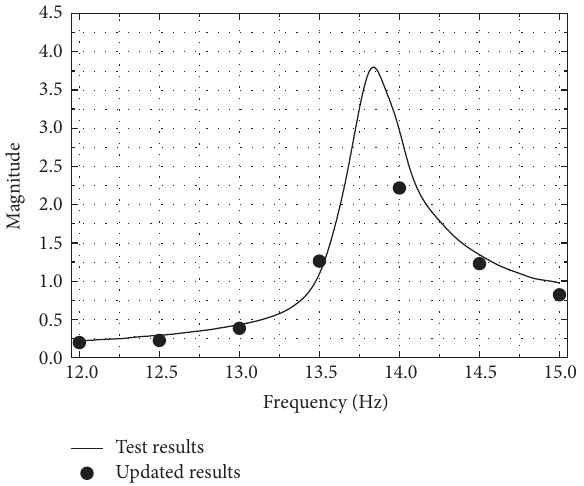
Figure 13: Measured and updated FRFs with 5N excitation.